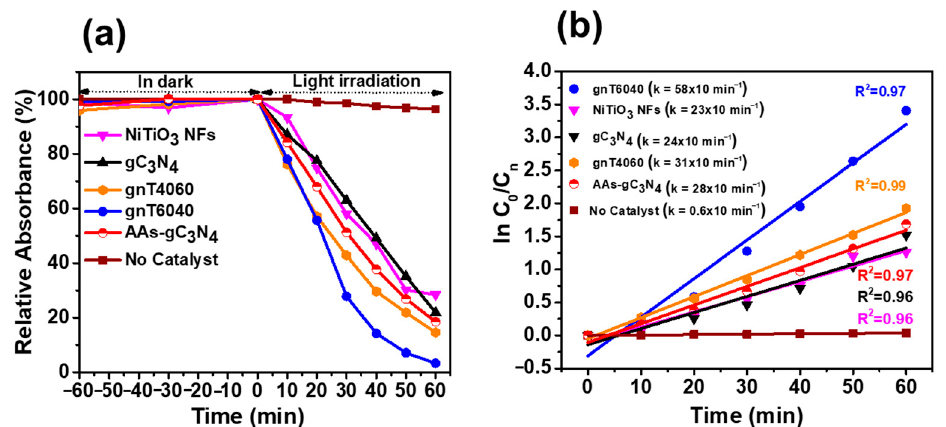
Figure 7. MB removal performance of NiTiO 3 NFs, gC 3 N 4 , AAs-gC 3 N 4 , and hybrid structures. ( a ) MB removal efficiency as a function of time and ( b ) reaction rate constants for the specified photocatalysts.